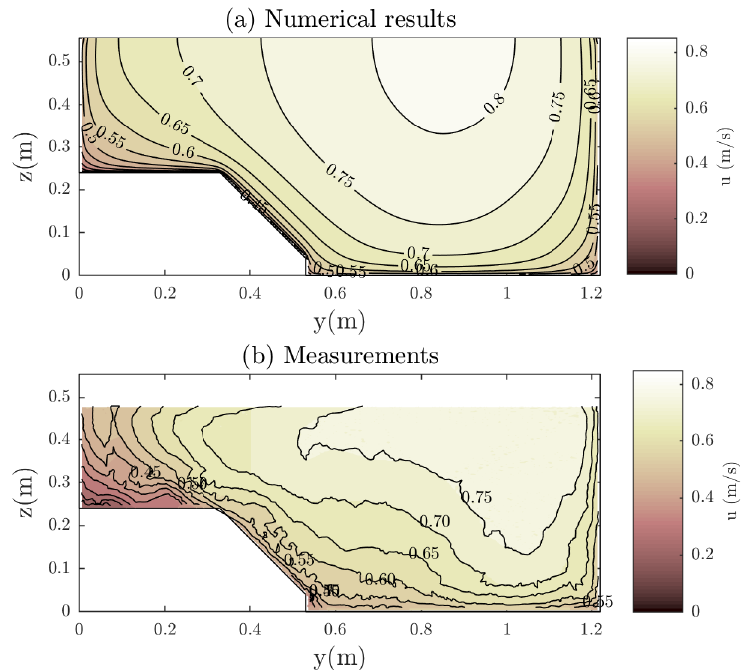
Figure 10. Comparison of calculated and measured streamwise velocity distribution in a compound channel of the experiments of Kean et al.